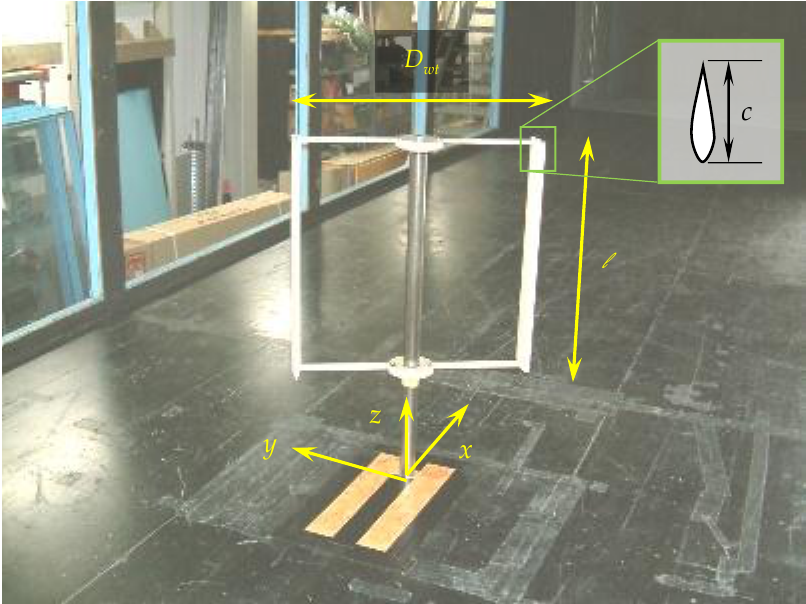
Figure 1. Vertical-axis wind turbine used in the wind tunnel experiments.